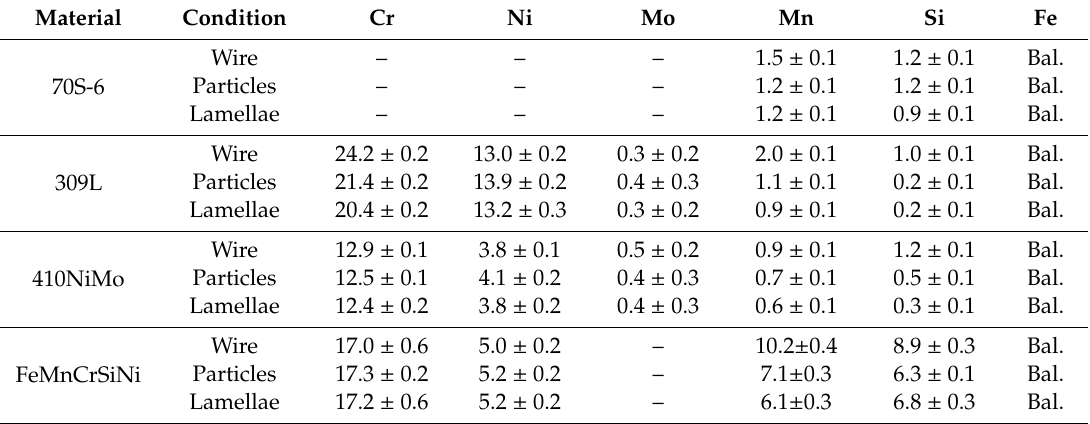
Table 3. Variation of chemical composition of sprayed materials (Mass %).